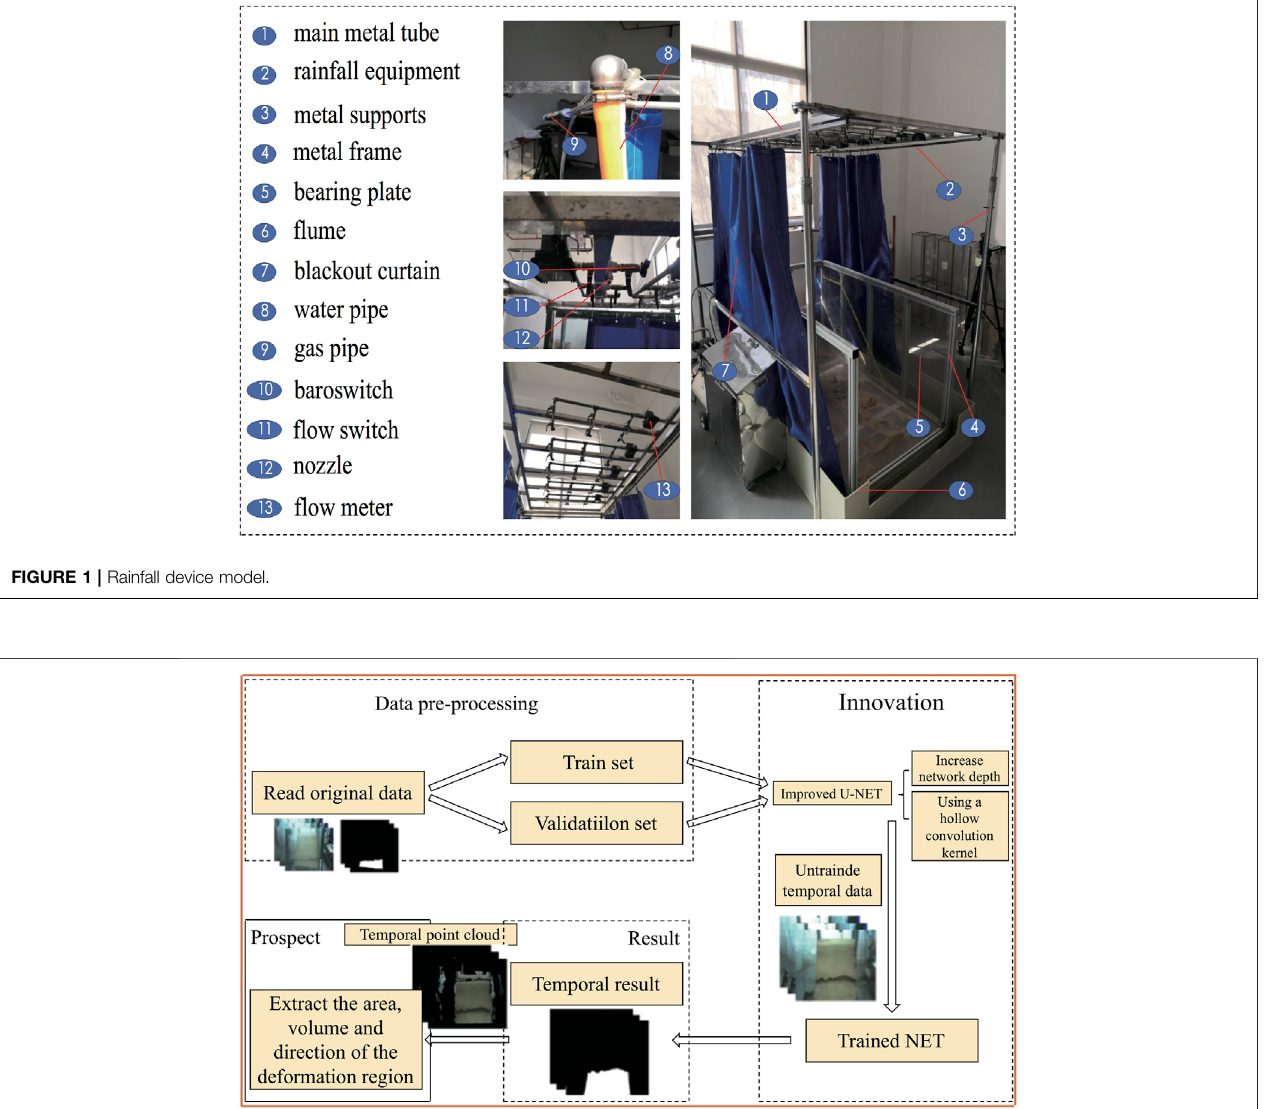
Frontiers in Earth Science |